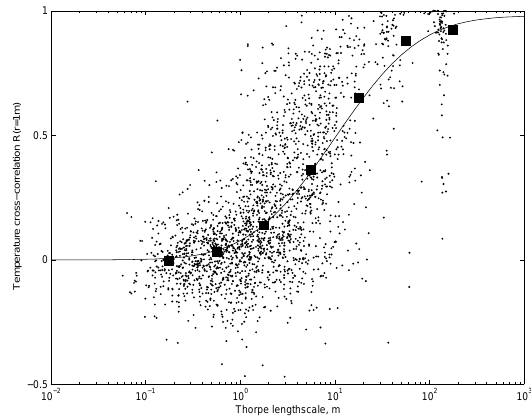
Figure 1. Dependence of cross-correlation of temperature fluctuations for a pair of sensors horizontally separated with distance r = 1 m on measured Thorpe length in different altitude segments during flight M1. Solid line shows approximation with formula (20) at a = 0.49 and L c = 10 m and thick black squares are median values of R(r) in different bands of L T values.